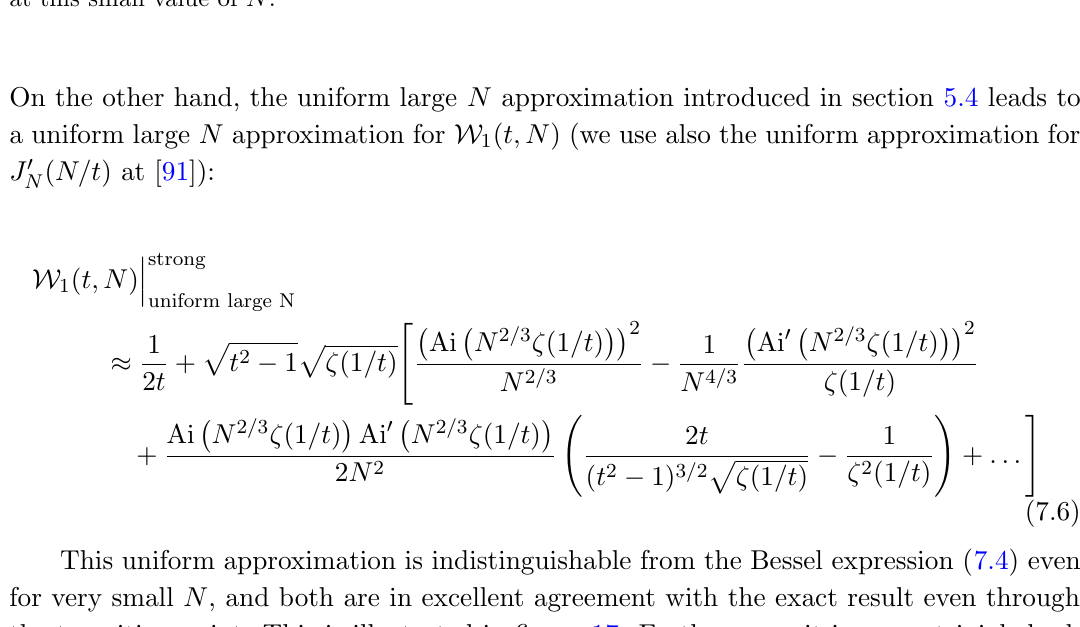
Figure 17 . The solid blue curve shows the Wilson loop W 1 ( t; N ) as a function of ’t Hooft coupling t , with N = 5. The red solid curve is the leading strong coupling approximation in (7.4), for which the uniform strong coupling approximation (7.6) is indistinguishable. The grey and black dashed lines show the leading terms of the conventional large N approximations for the weak and strong coupling regimes, respectively. Note that the conventional large N approximations diverge at t = 1, while the uniform approximation is smooth and in excellent agreement with the exact result, even at this small value of N